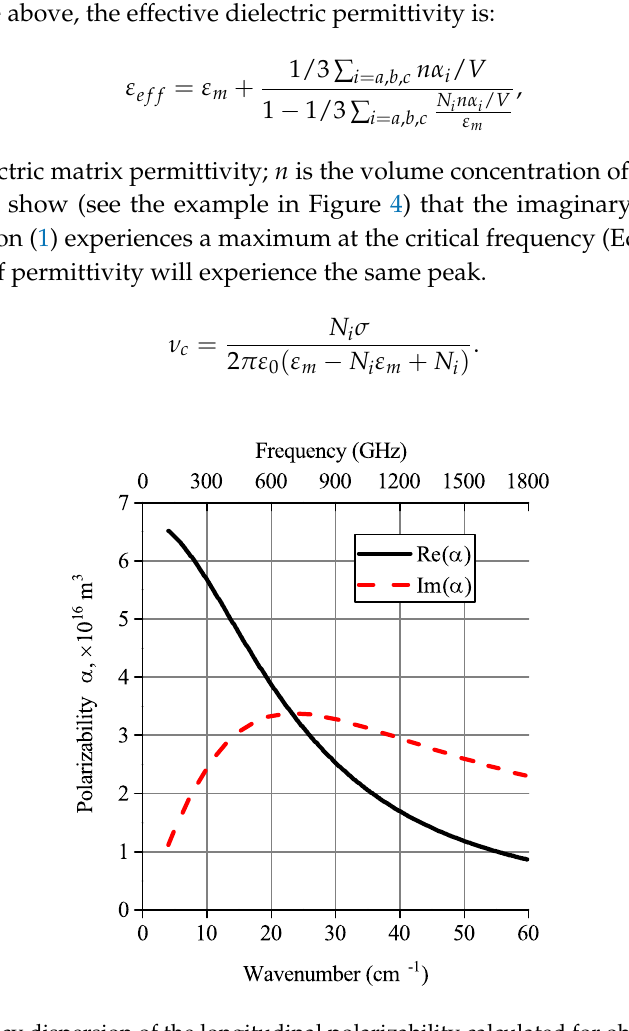
Figure 4. Frequency dispersion of the longitudinal polarizability calculated for oblate ellipsoid with a = b = 5 µ m, c = 25 nm (i.e., AR = 200), σ = 10,000 S/m and ε m = 2.5 − 0.1 i